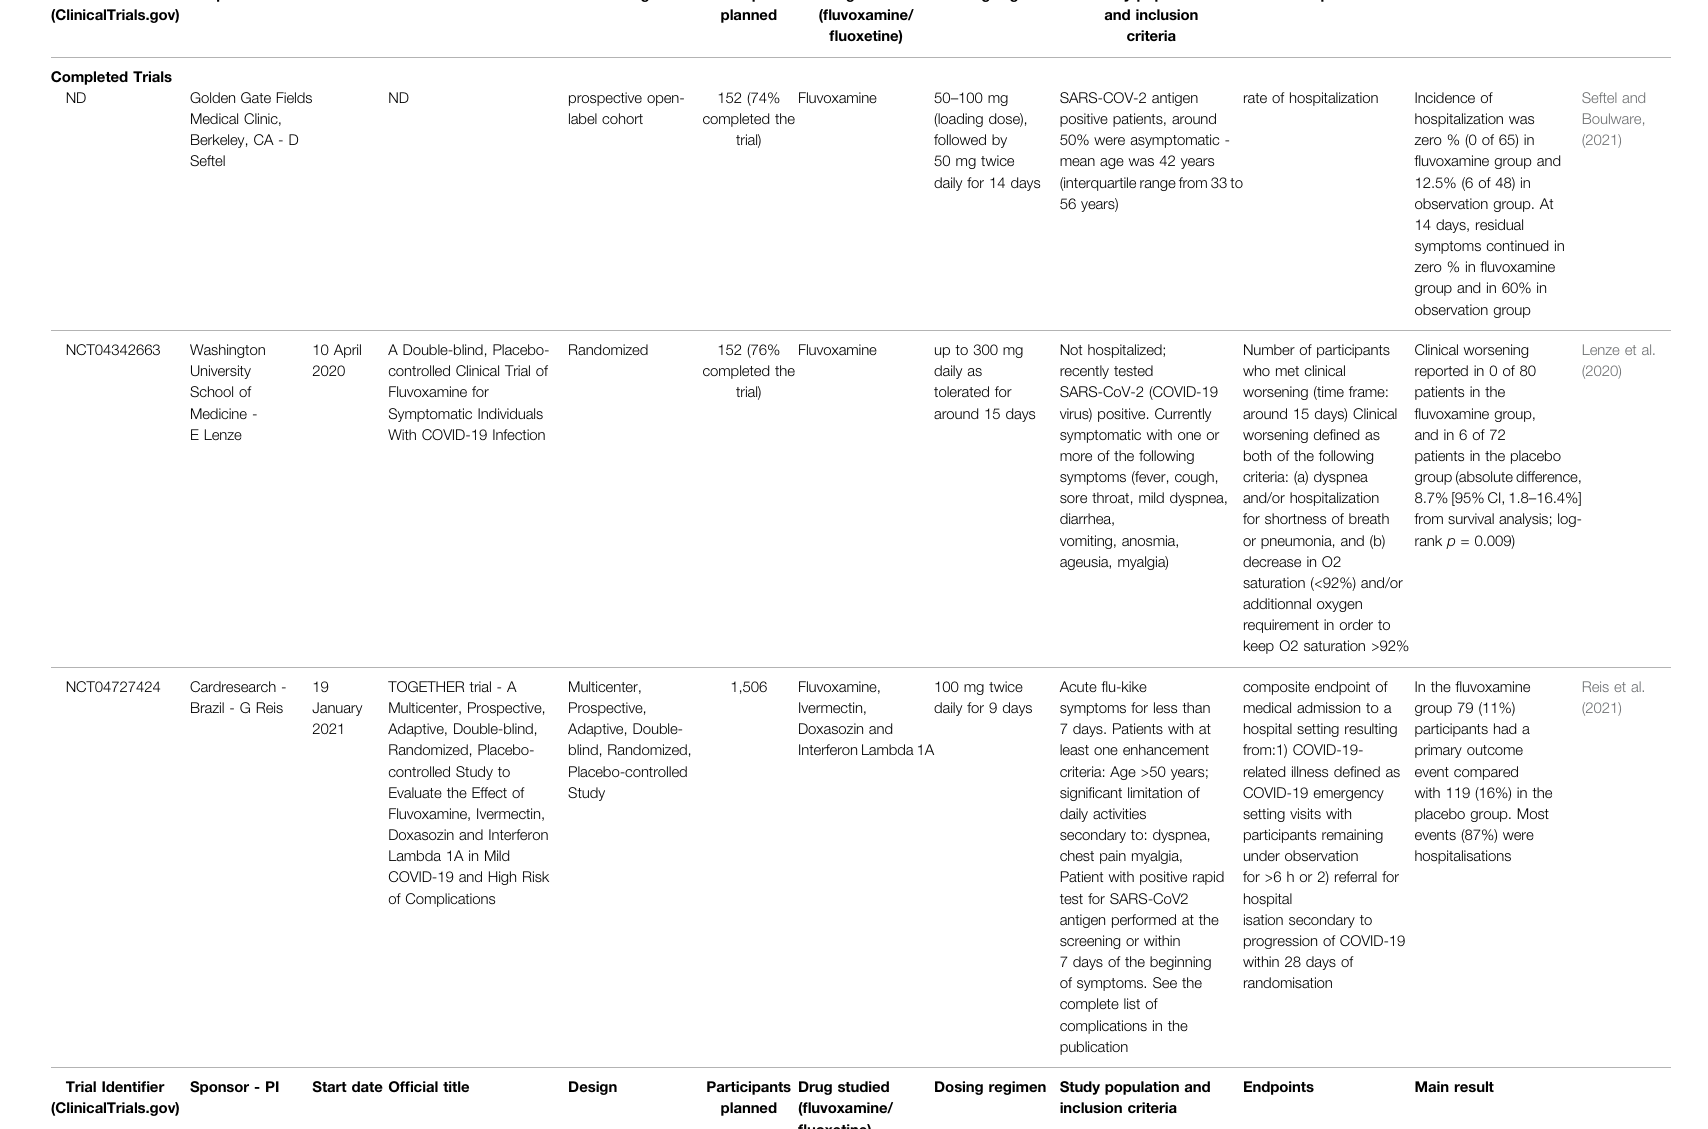
TABLE 1 | Main features of completed, ongoing, suspended and withdrawn trial on fl uvoxamine and fl uoxetine in patients with COVID-19. Trial identi fi er